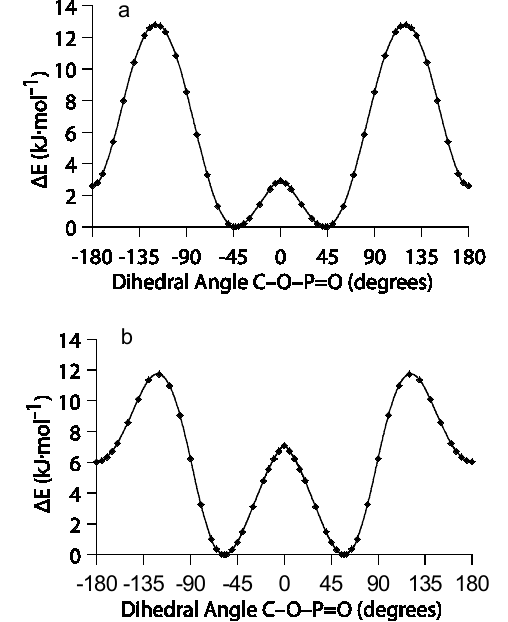
Figure 3. Barriers to internal rotation in the molecules of methyl dichlorophosphate (a) and phenyl dichlorophosphate (b) calculated at the DFT(PBE0/6-31G(2df,p) level of theory.